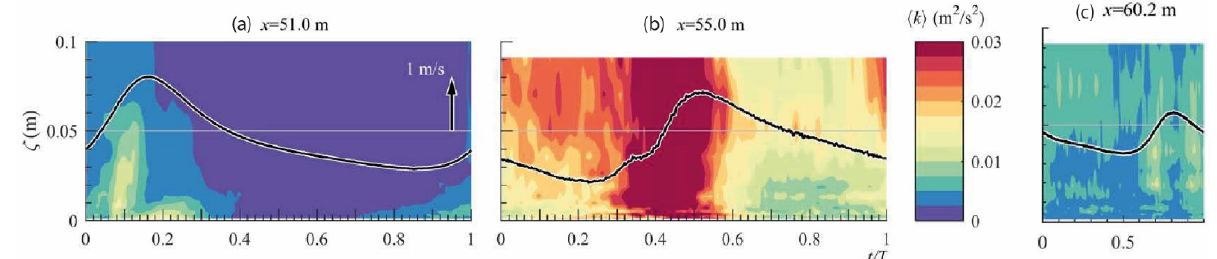
Figure 14. Time series of depth-varying phase-averaged turbulent kinetic energy (< k >) in the lower 10 cm of the water column for ( a ) shoaling waves ( x = 51.0 m), ( b ) plunging breakers ( x = 55.0 m), and ( c ) surf bores ( x = 60.2 m). x indicates the along-flume distance from the wave generator and the magnitude of < k > is indicated by the right-hand scale. The free-stream velocity is shown in each panel by the black line. Modified from van der Zanden et al. [99].